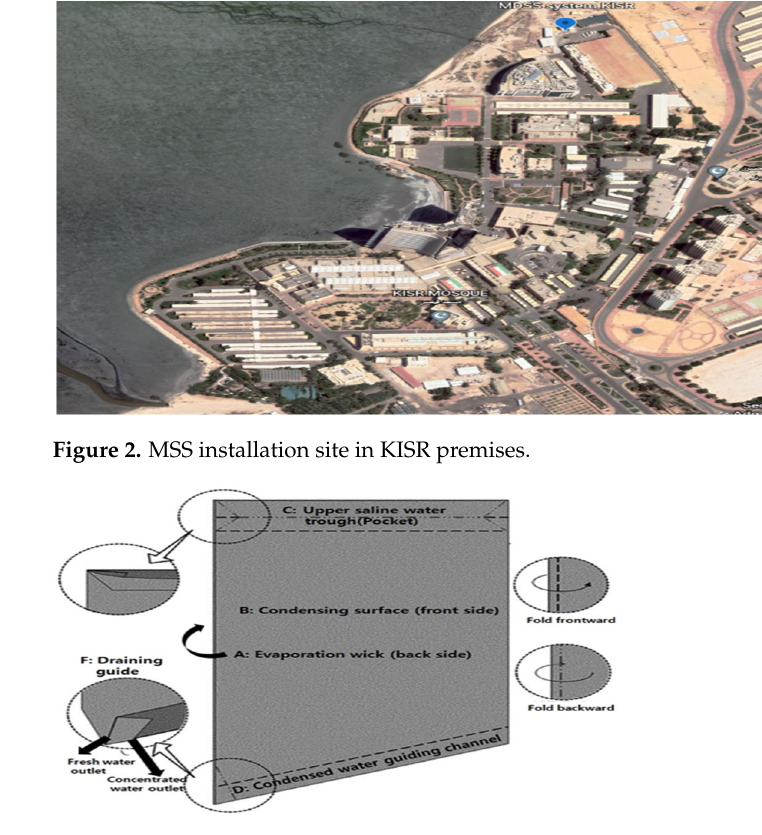
Figure 3. Basic origami structure of wick and condenser layer.